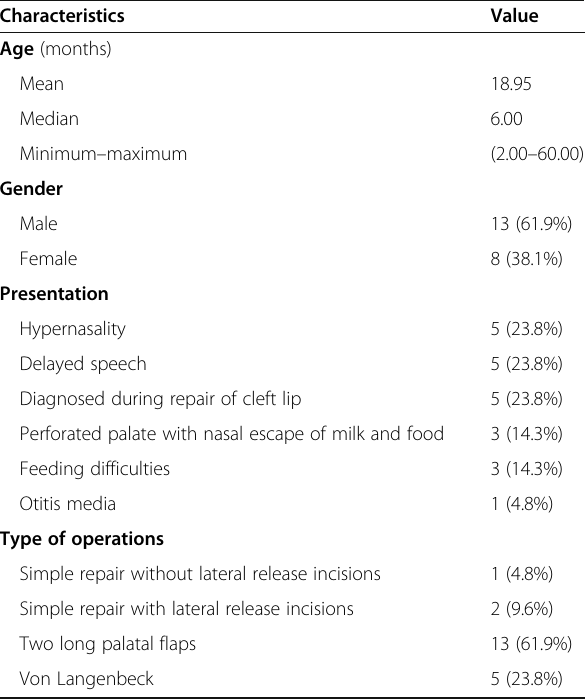
Table 1 Demographic and clinical characteristics of patients (